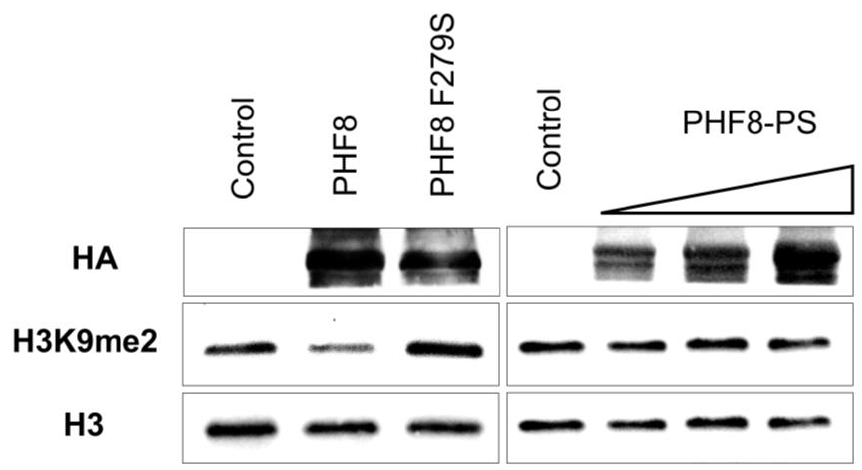
Figure 3. Characterization of PHF8-PS demethylase activity. Histone demethylase assays on bulk histones with PHF8 and PHF8-PS proteins purified from HEK293 cells overexpressing Flag/HA- tagged PHF8, PHF8 catalytic mutant (PHF8 F279S), and PHF8-PS. PHF8-PS demethylase assays were performed with an increasing number of proteins. Proteins were purified on FLAG tag and analyzed by Western blotting as indicated.